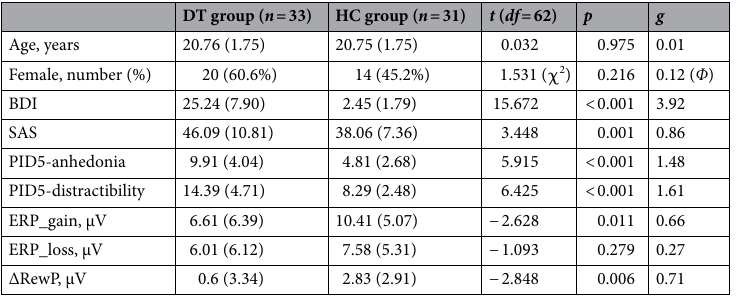
Table 1. Demographics, self-reported data and the ΔRewP for the participants with/without depressive tendencies. DT group group of participants with depressive tendency, HC group group of participants without depressive tendency, BDI Beck Depression Inventory-II, SAS Self-Rating Anxiety Scale, PID5-Anhedonia the anhedonia subscale of the personality inventory for DSM-5, PID5-Distractibility the distractibility subscale of the personality inventory for DSM-5, ΔRewP difference of mean amplitudes 250–350 ms after gain and loss feedback at FCz. Values are mean (SD); g , effect size.